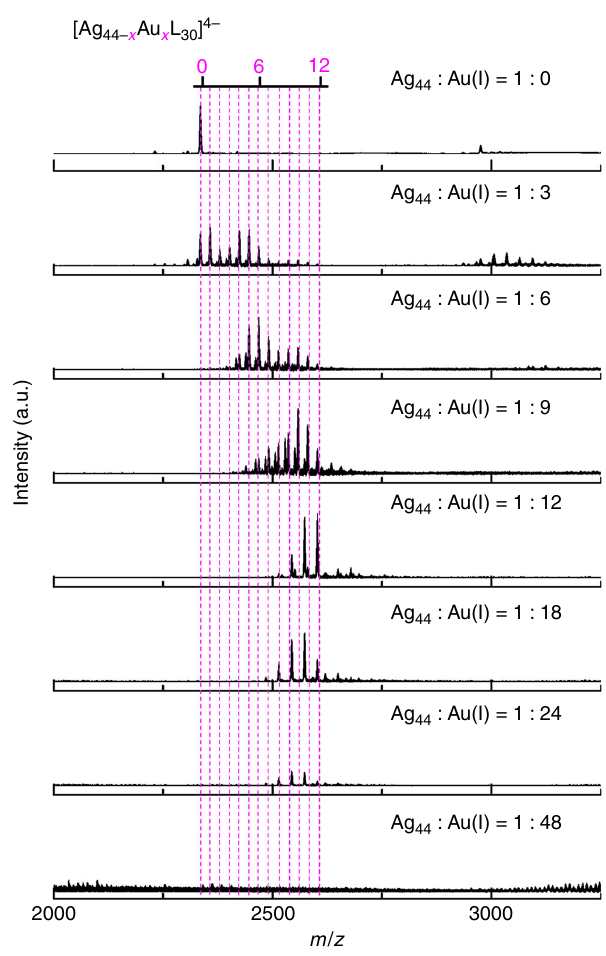
Fig. 2 Reaction of Ag 44 nanoclusters with varied dose of Au(I) – SR complexes. Electrospray ionization mass spectra of [Ag 44 − x Au x L 30 ] 4 − nanoclusters synthesized at varied feeding ratios of Ag 44 -to-Au(I), R Ag44/Au(I) . The ligand (L) is thiolate (SR) or halogen (i.e., Cl). The dotted lines indicate the number of Au heteroatoms in each